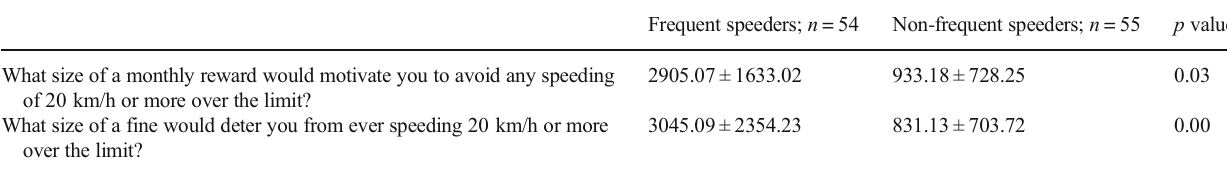
frequency of speeding in relation the magnitude of fines/rewards in motivating a behavior